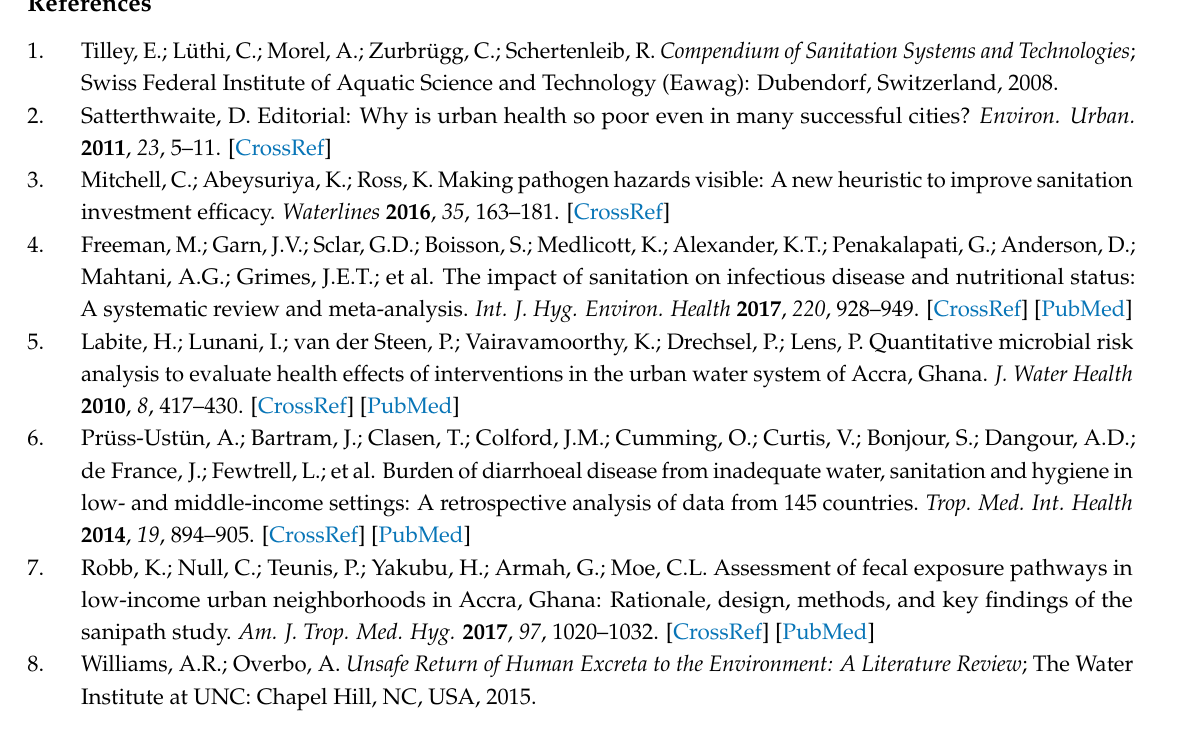
Supplementary Materials: The following are available online at http://www.mdpi.com/s1, Table S1: Pathogen inputs, Table S2: Pathogen log 10 reduction assumptions, Table S3: Steps in the QMRA Calculations, Table S4; Exposure volume, Table S5. Exposure frequency and exposed population, Table S6: Environmental data use to validate the range of concentration at exposure points and to adjust the dilution, Table S7: Option modifications as analysed in the model and referred to in Table 2 of the main text, Figure S1: Inputs to model for Dhaka Bangladesh Base